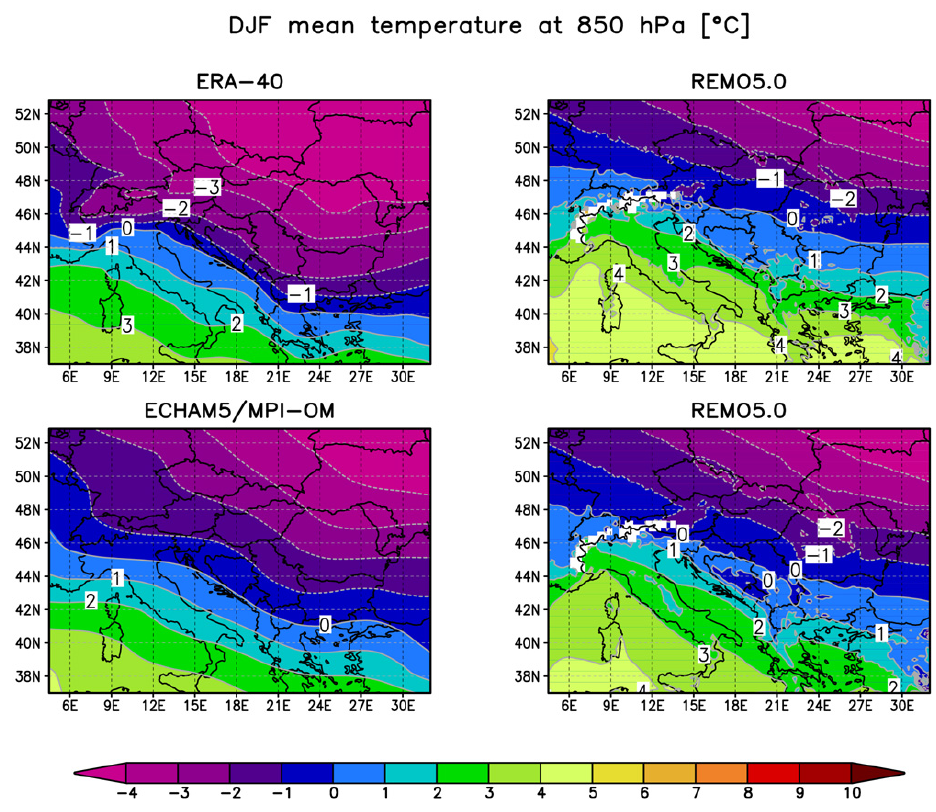
Figure 2. Winter mean temperature [ ◦ C] at the level of 850hPa in the REMO simulations (top right: ERA40-driven REMO, bottom right: ECHAM-driven REMO) and the corresponding global fields (top left: ERA40, bottom left: ECHAM5 / MPI-OM) for